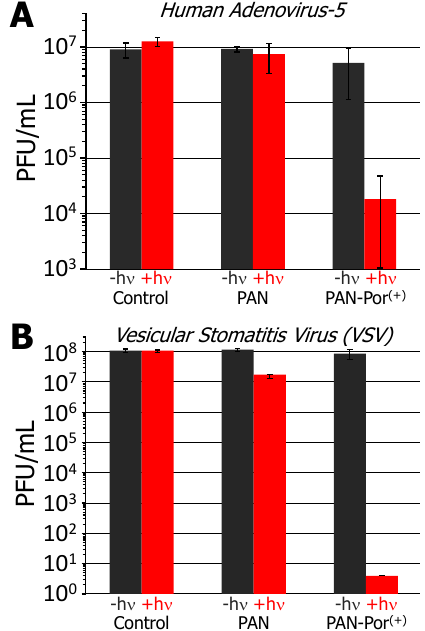
Figure 4. Antiviral photodynamic inactivation studies employing PAN-Por (+) against ( A ) human adenovirus-5 (HAd-5) and ( B ) vesicular stomatitis virus (VSV). The black and red bars represent the number of PFU/mL of the non-illuminated (dark) and illuminated conditions, respectively, for the material-free (control), photosensitizer-free (PAN only) control, and PAN-Por (+) studies. The illumination conditions and error bar visualizations were as described in Figure